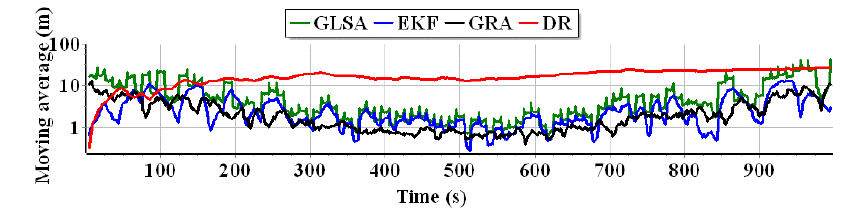
Figure 9. Moving average distance to reference position from the estimated position during a single SV crossing as a function of time (logarithmic scale—log base = 10).